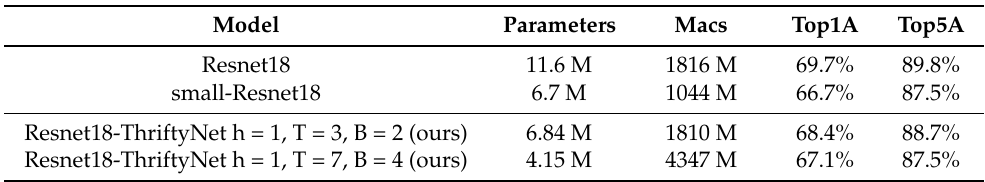
Table 5. Comparative results on ImageNet ILSVRC 2012, considering Top 1 Accuracy (Top1A), Top 5 Accuracy (Top5A), number of parameters and number of operations